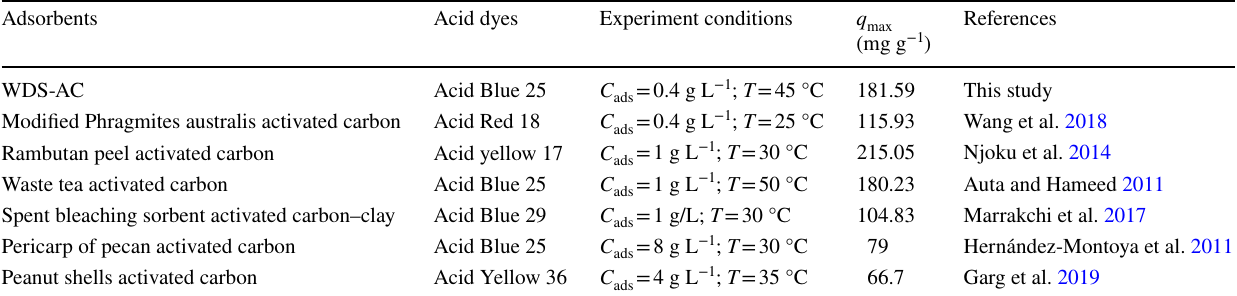
Table 7 Comparison of maximum monolayer adsorption capacities of acid dyes onto various adsorbents reported in the literature